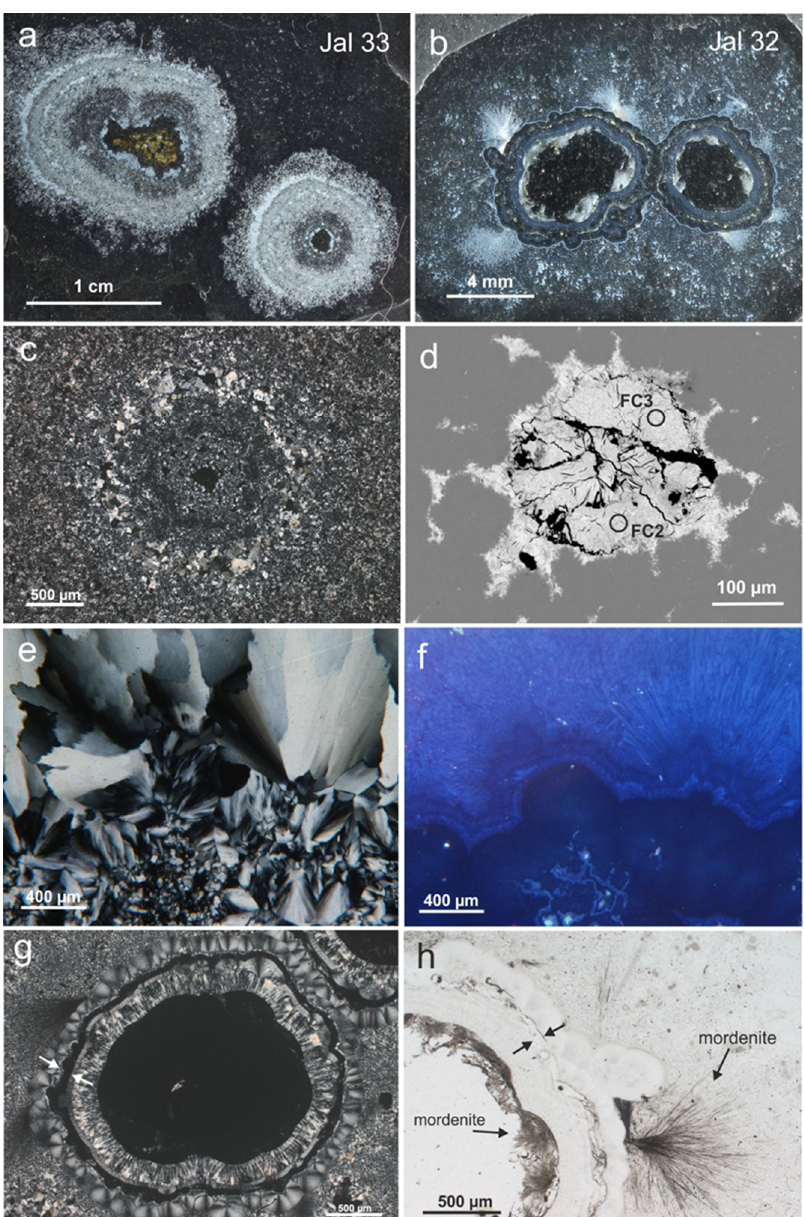
Figure 10. Microstructural features of two filamentous cores from Jalgaon/Savda, India: ( a ) cross-section of two conical SFF with filamentous cores showing a dark-brownish filament center (sample Jal 33); ( b ) cross-section of SFF with two empty filamentous cores (sample Jal 32); ( c ) micrograph in transmitted light (crossed polars) of the central part of the right filamentous core in Figure 10a; the dark core is encrusted by concentric layers of chalcedony showing varying grain size; ( d ) SEM-BSE image of the filamentous core in sample Jal 33 (compare (c)) with bright contrast due to high Fe contents and irregular dark fissures; FC2 and FC3 mark the analytical points of EDX measurements (see data in Table S1); ( e/f ) transmitted light (crossed polars (e)) and CL (f) images showing textural details of the SiO 2 mineralization sequence; ( g ) micrograph in transmitted light (crossed polars) of the central part of the filamentous core in (b) (sample Jal 32), the core being empty and surrounded by concentric layers of fine-grained and fibrous SiO 2 ; the arrows point to an empty concentric layer within the silica succession; ( h ) close-up of the central part of sample Jal 32; mordenite crystallized inwards to the central hole and within the silica matrix; note the empty space (arrows) between the silica layers.